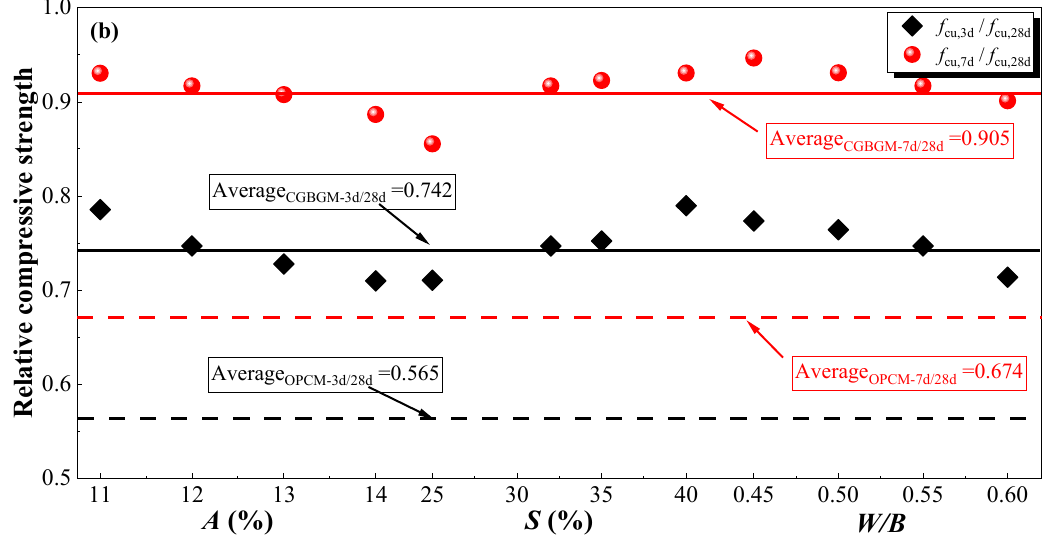
Figure 6. Relative strength of the CGBGM: ( a ) relative flexural strength; ( b ) relative compressive strength.